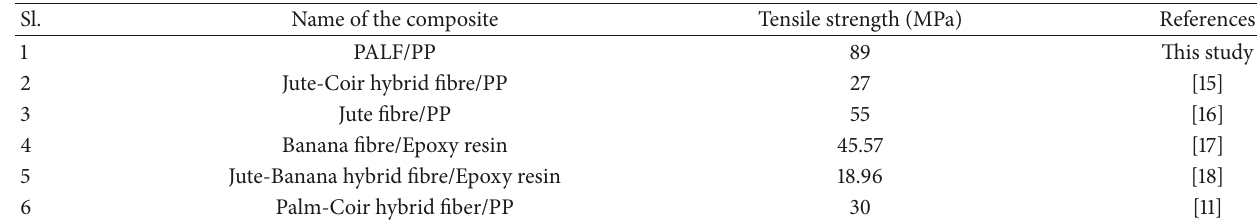
Table 2: Comparison of mechanical